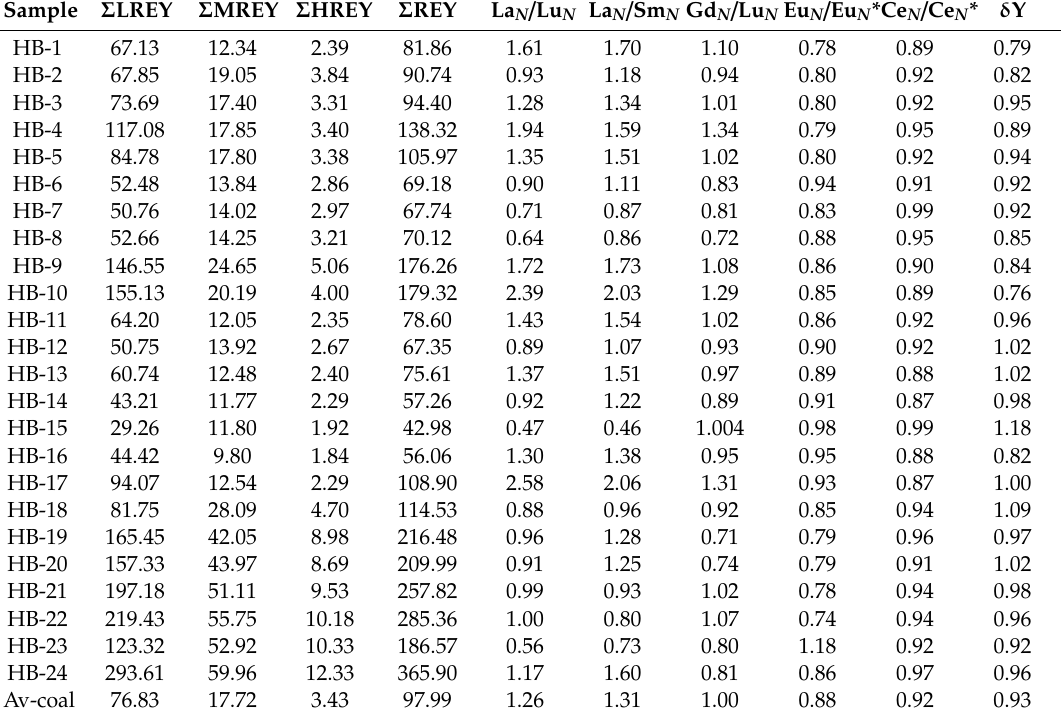
Table 6. REY geochemical parameters for the No. 2 1 coal and non-coal samples from the Hebi No. Table6. REYgeochemicalparametersfortheNo. 2 1 coalandnon-coalsamplesfromtheHebiNo.6mine. 6 mine. Sample Σ LREY Sample Σ LREY Σ MREY Σ HREY Σ REY